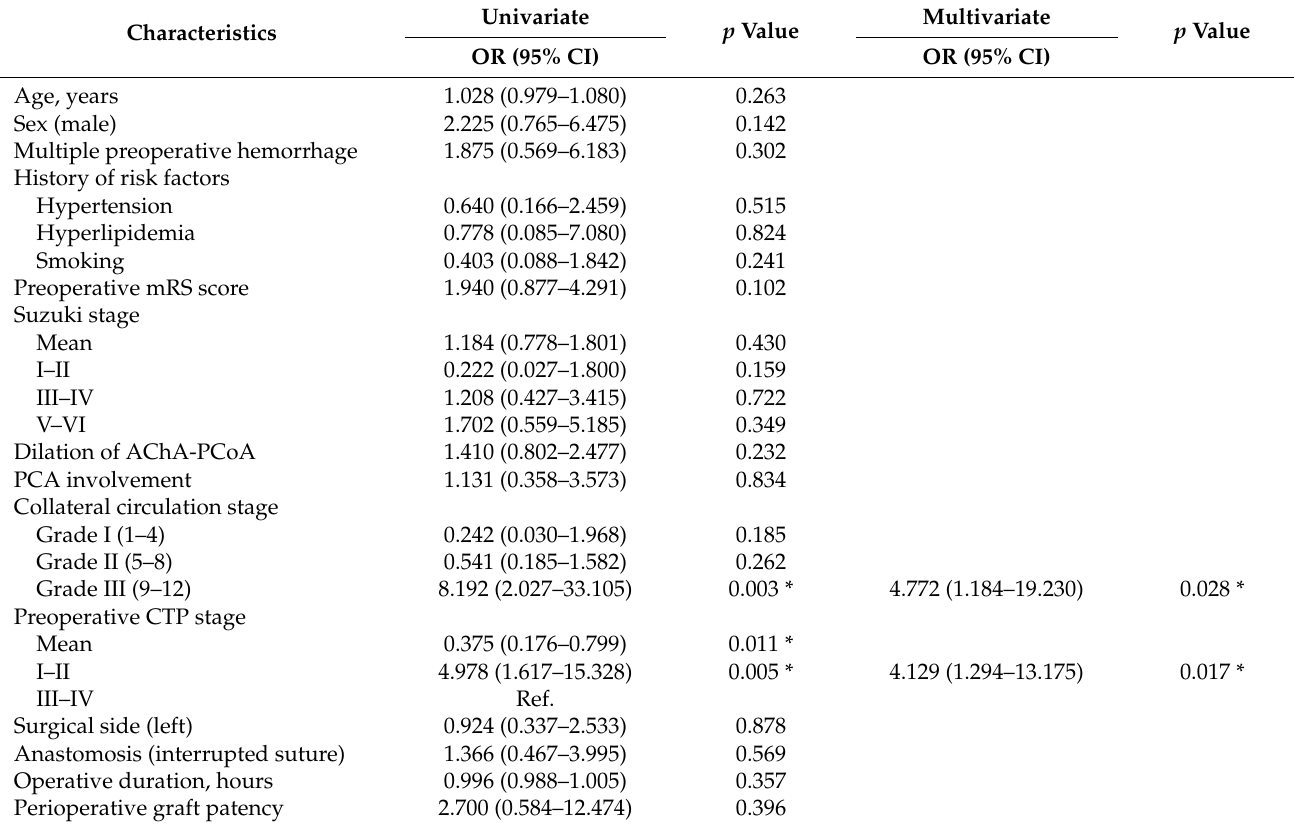
Table 4. Predictors of delayed anastomotic occlusion in adult hemorrhagic moyamoya